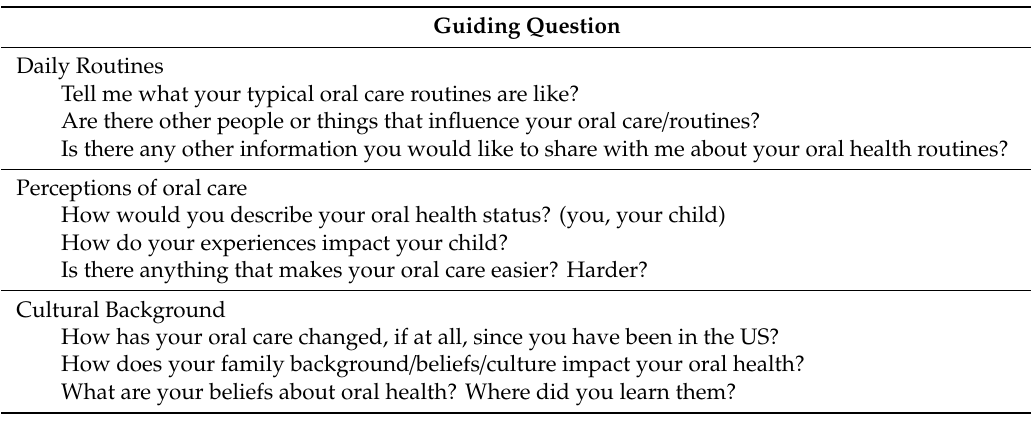
Table 1. Interview guide questions.